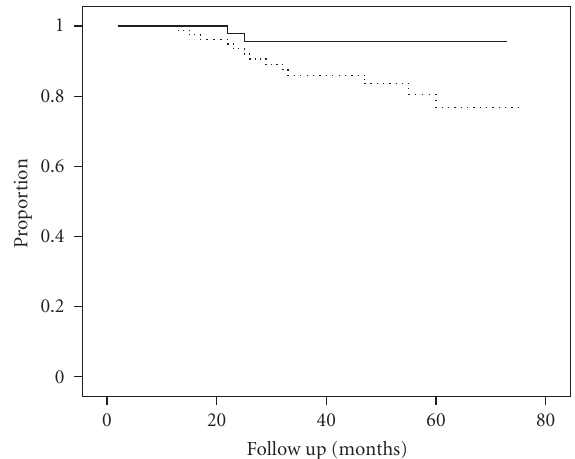
Figure 2: Actuarial probability curve of remaining free of recurrent symptomatic CBD stone after complete removal of the initial CBD stone with subsequent cholecystectomy. The patients with single CBD stone versus those with multiple CBD stones (96.8% versus 84.0%, resp.; P = 0 . 04, log-rank test) (---The patients with multiple CBD stones, or —the patients with single CBD